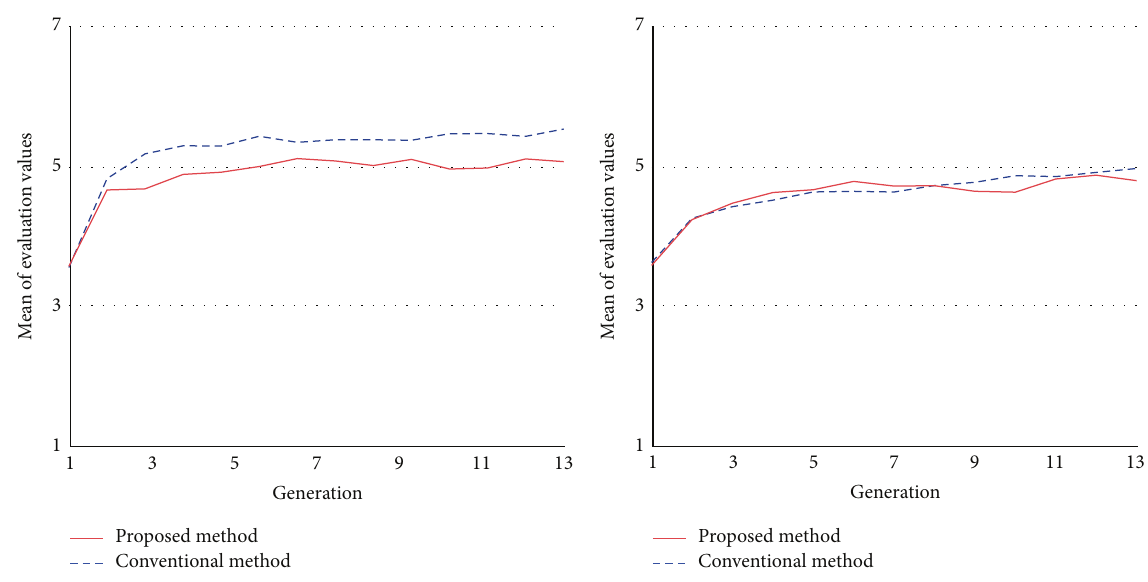
Figure 19: Mean of the evaluation values of population in each generation. The results of the proposed method are depicted by the solid red lines and those of the conventional method by the dotted blue lines. The number of landscapes is the number of trials by each method and means the number of samples.